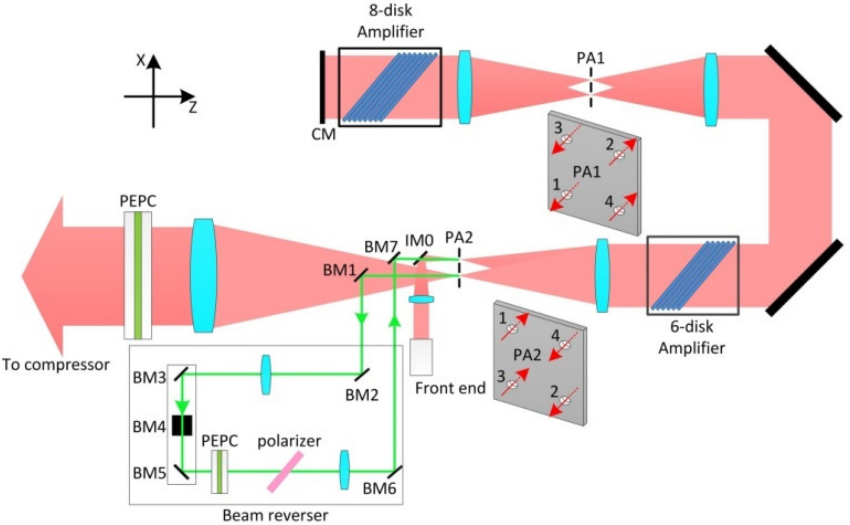
Figure 1. Schematic diagram of main amplifier subsystem of XG-III beamline.